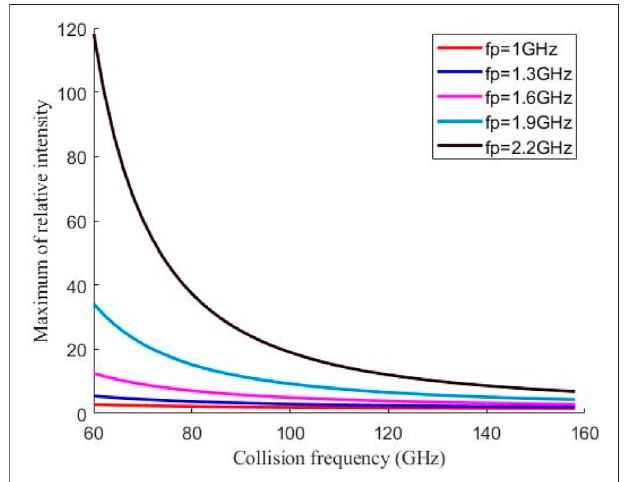
FIGURE 7 | The in fl uence of different collision frequencies on the intensity distribution with f i = 2.1 GHz and f p = 2 GHz.